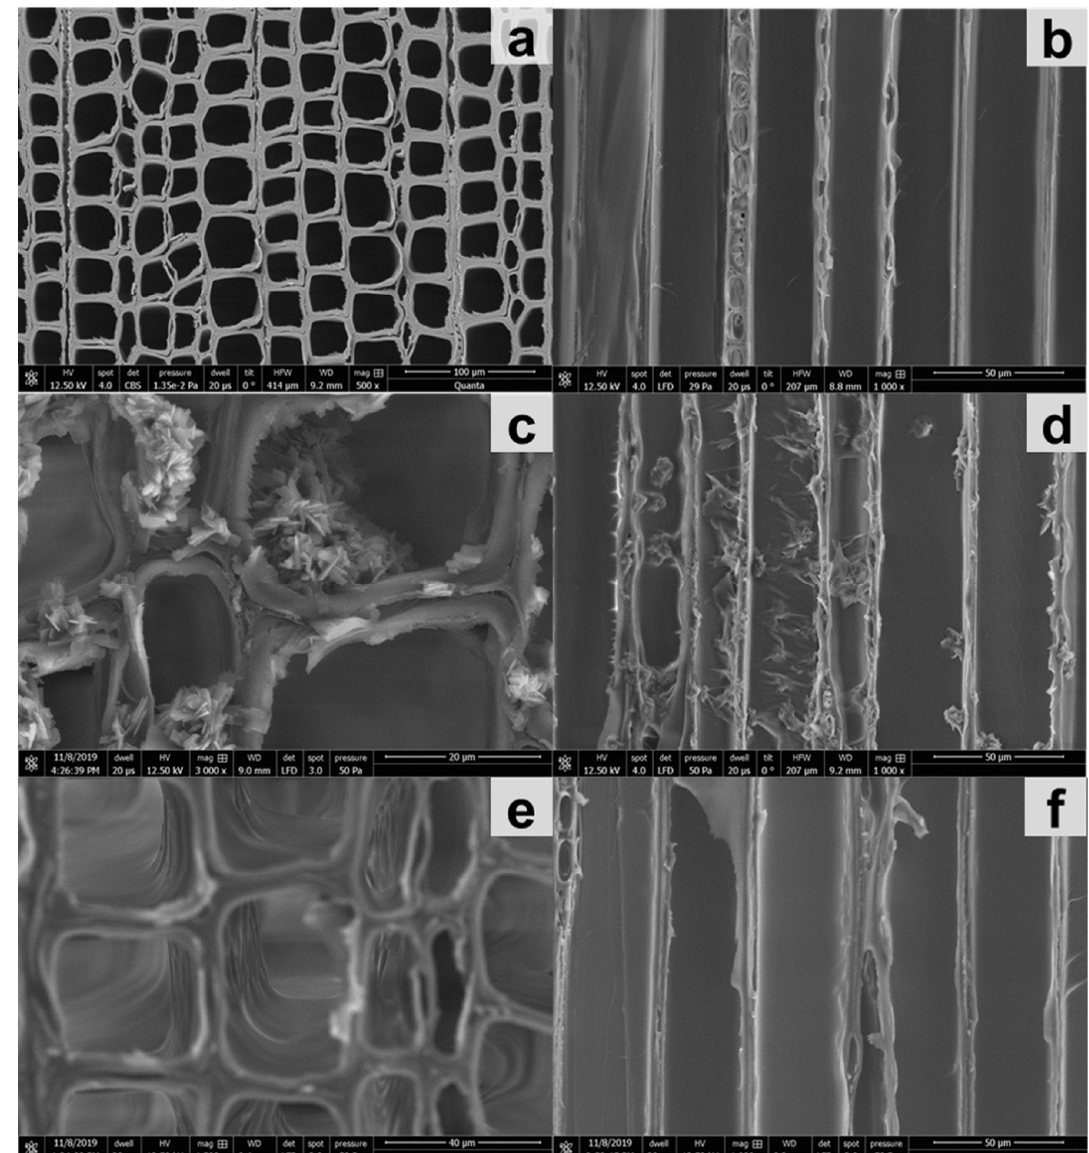
Figure 7. SEM micrographs of Scots pine sapwood ( Pinus sylvestris ) treated with extractives. ( a , b ) Untreated Scots pine sapwood. ( c , d ) Scots pine sapwood block treated with the heartwood extract of black locust (HWE). ( e , f ) Scots pine sapwood block treated with knotwood extract of Scots pine (KWE). ( a , c , e ) Transverse sections. ( b , d , f ) Longitudinal sections. The images were obtained at magnifications of 1000×, 1300×, 2500× and 8000×.